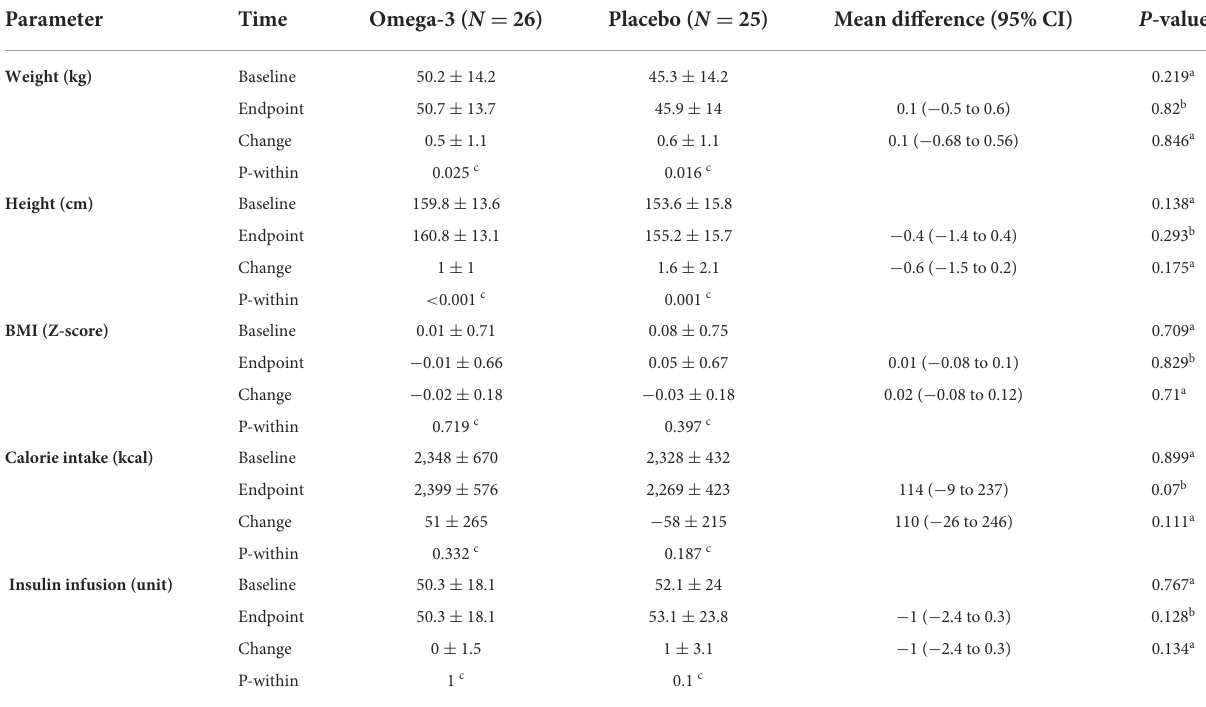
TABLE 1 Participant characteristics before and after supplementation with